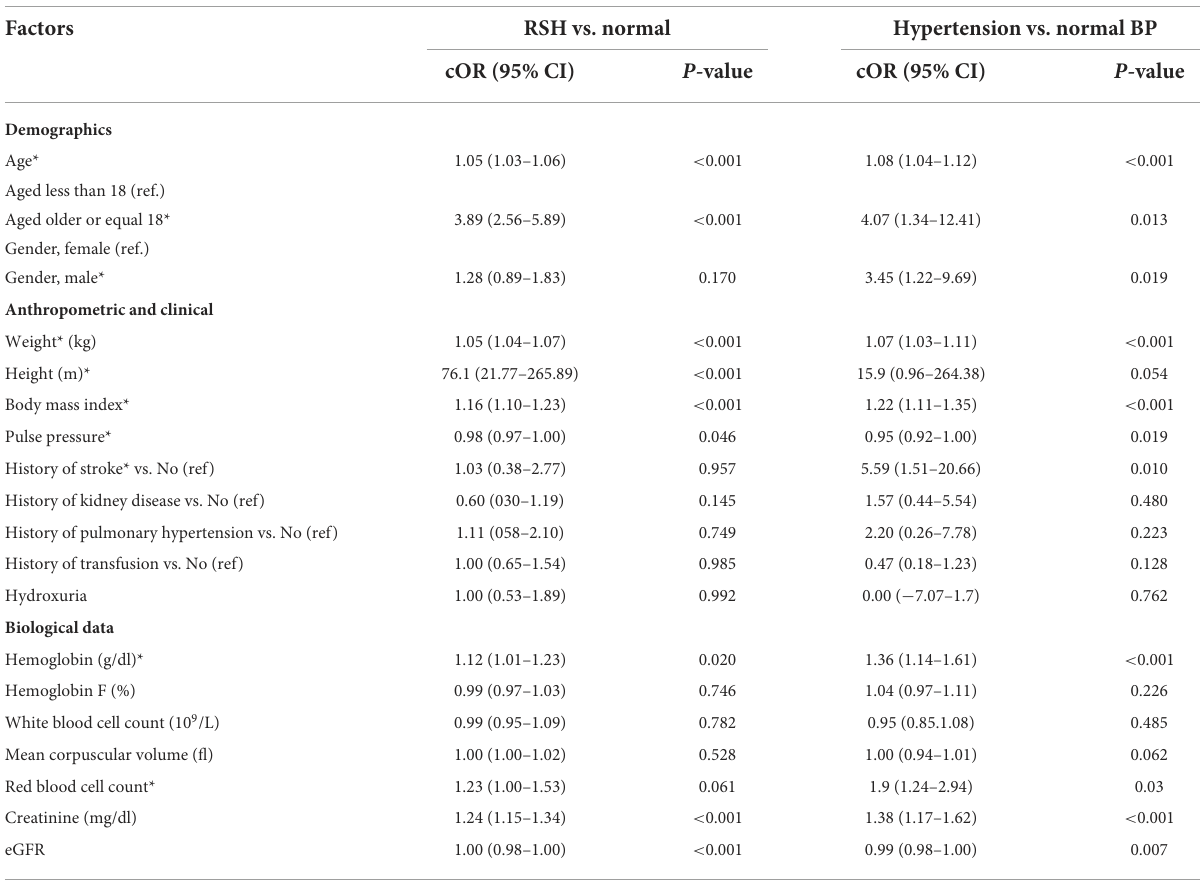
TABLE 2 Univariate multinomial logistic regression analyses of factors associated with RSV and hypertension among SCD patients in Cameroon (reference: Normal BP). Factors RSH vs.